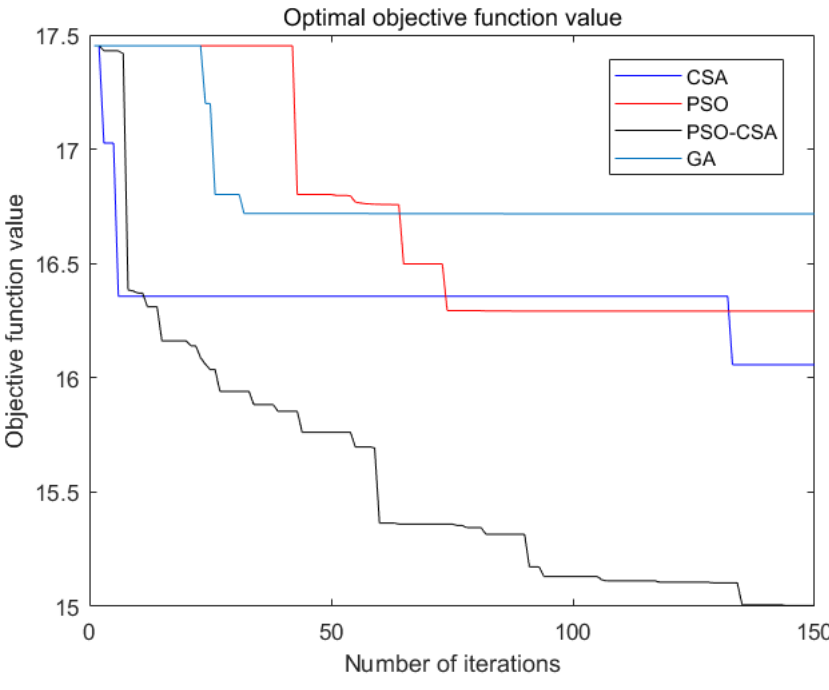
Figure 3. Optimal convergence curves for the four algorithms.